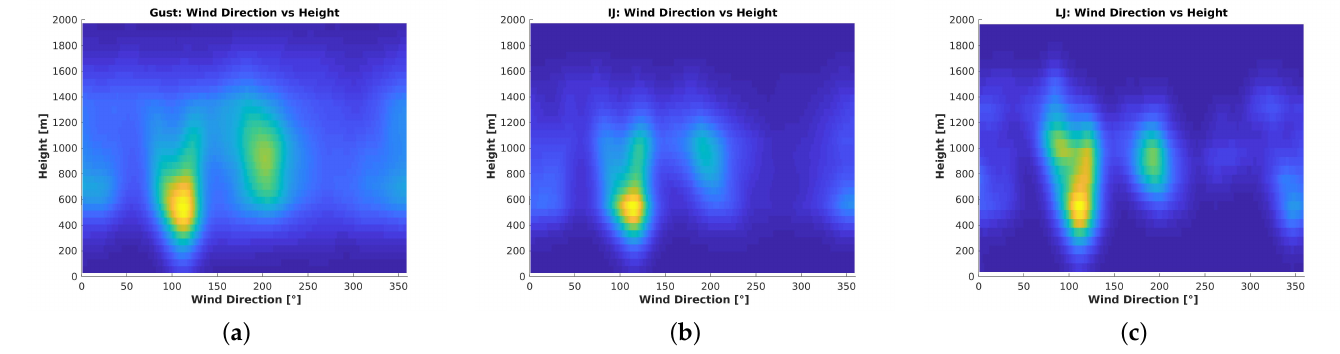
Figure 15. Distribution of wind direction and height of the three wind events. The colour blue (low) to yellow (high) in arbitrary units indicate the relative frequency of the corresponding events for 2013–2021. ( a ) Gusts, ( b ) Intermediate Jets, ( c ) Long